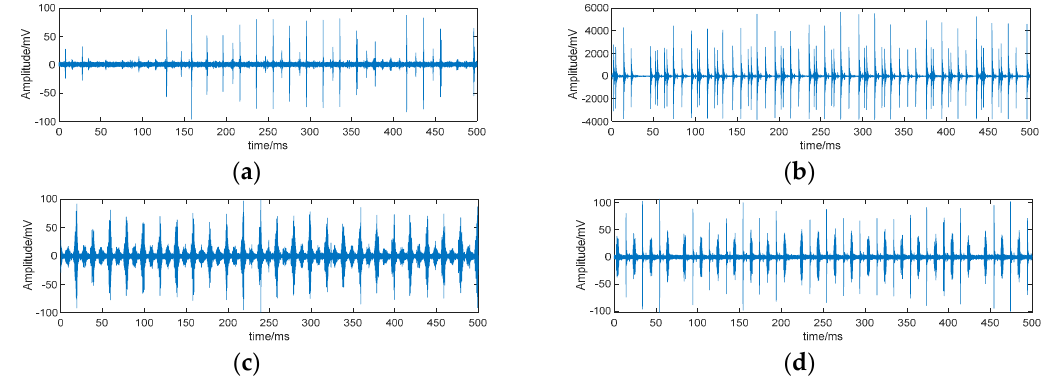
Figure 6. Collected and denoised ultrasonic partial discharge (PD) signals of GIS with different defects. ( a ) Free metal particles; ( b ) Floating electrode; ( c ) Creeping discharge; ( d ) Metal protrusions.